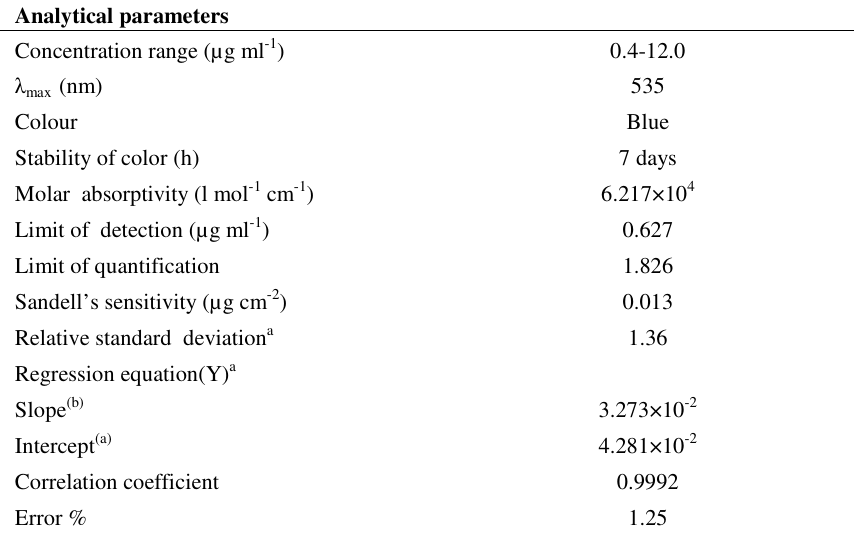
Table 4 Optical characteristics precision and accuracy of the method using azure-B Analytical